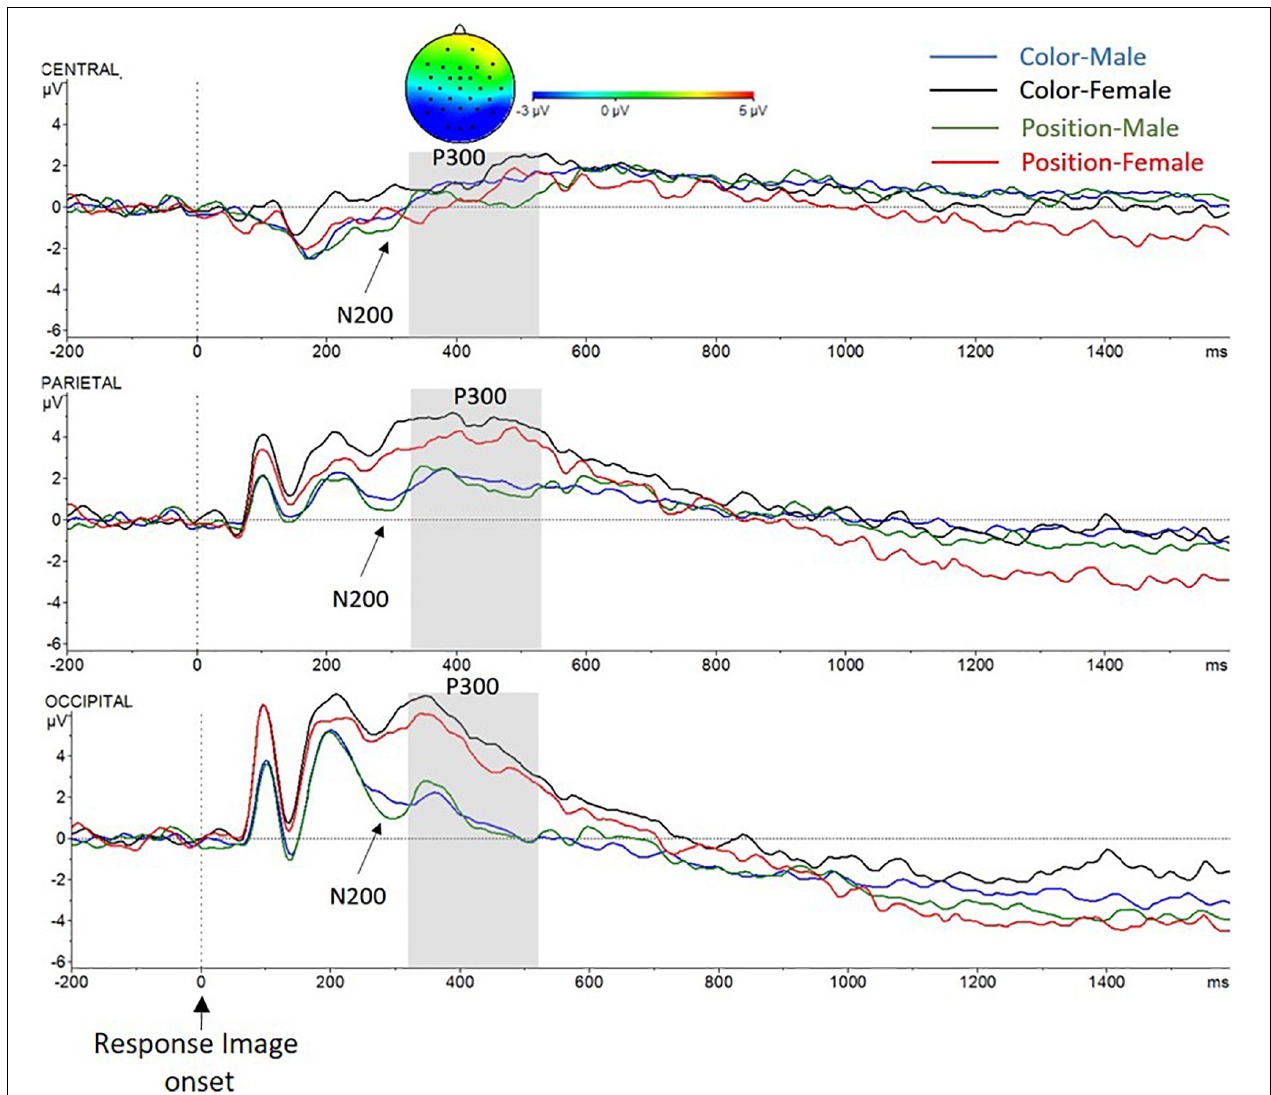
FIGURE 8 | Grand-average voltage data (in mV) of ERP in the Retrieval phase in ROI, as a function of Criteria and Sex (Color Men, blue line; Color Women, black line; Position Men, green line; and Position Women, red line). Gray shades represent the P300 time window. On the top, topographic map of the difference in ERP waves due to Sex (Men–Women) in the P300 time window. Time zero represents Response Image onset. P300. Time window from 350 to 550 ms after the Response Image